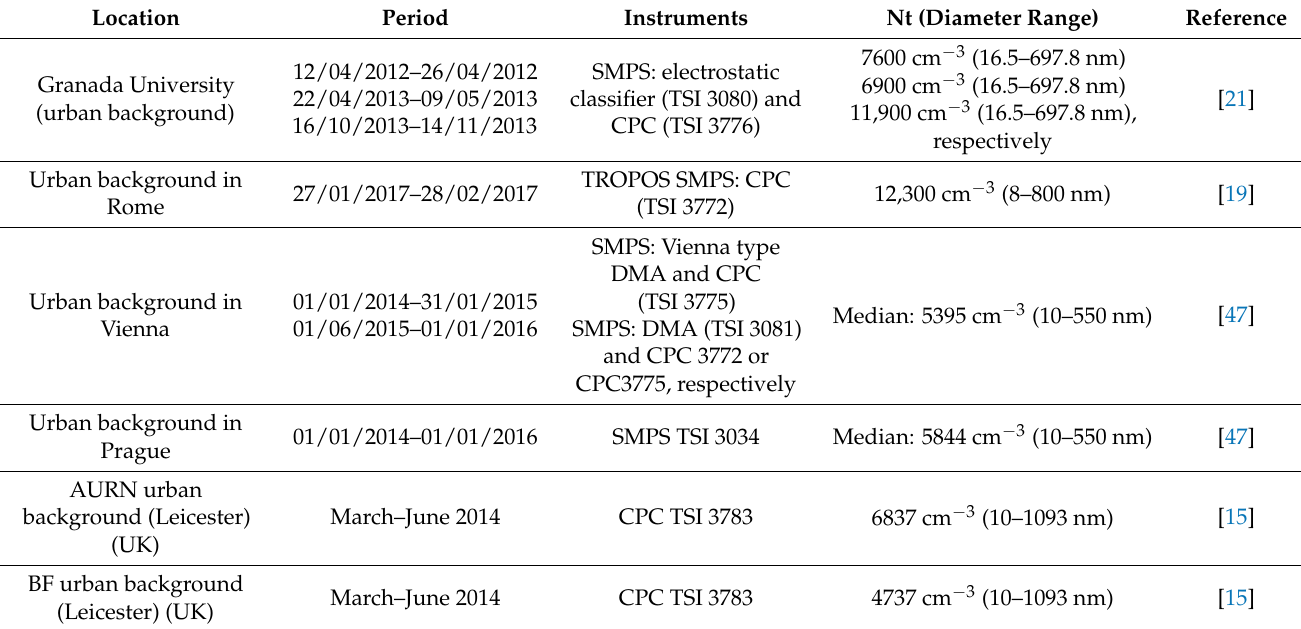
Table 2. Average total number of particles (Nt) concentrations in different European cities. Period, instrument, diameter ranges and references are